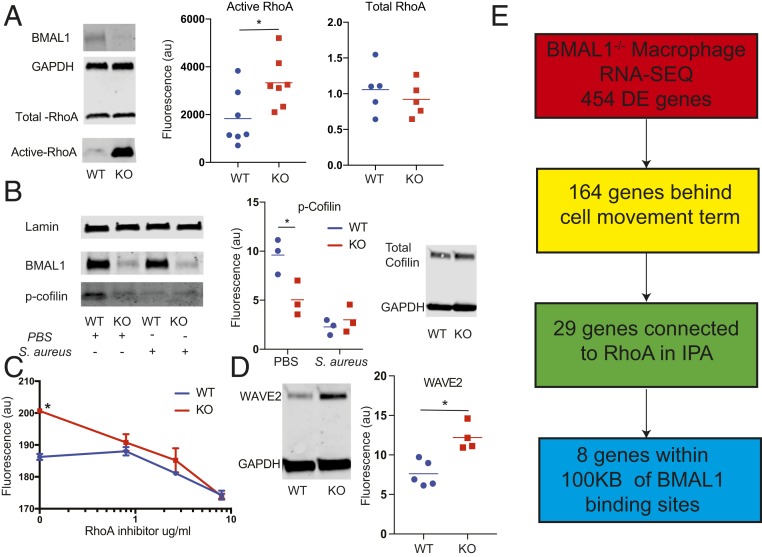
Bmal1 deletion increases RhoA activation, and inhibition of RhoA rescues the phagocytosis phenotype. (A) Peritoneal macrophages from LysM-Bmal1−/− (KO) and floxed littermate controls (WT) were cultured under control conditions for 24 h after harvest. Cells were lysed and analyzed for BMAL1, GAPDH, total RhoA, and active RhoA. Active and total RhoA abundance was quantified, after normalization to GAPDH. *P < 0.05. (B) Macrophages (WT and KO) were activated with heat-killed S. aureus for 30 min before protein lysate was analyzed for phospho, and total cofilin, with BMAL1, and lamin as controls; *P < 0.05 by Mann–Whitney U test. (C) Macrophages (WT and KO) were cultured for 24 h postrecovery from animals and then subjected to a live cell phagocytosis assay with labeled S. aureus. Cells were incubated with the CT004 RhoA inhibitor at the indicated concentrations from 1 h before adding bacteria (n = 4 per dose). Mean and SD are shown; *P < 0.05 by Mann–Whitney U test. (D) Macrophages (WT and KO) were cultured for 24 h postrecovery from animals under control conditions before lysis and analysis for WAVE2 expression by immunoblot; *P < 0.05 by Mann–Whitney U test. (E) Schematic diagram showing how 164 genes involved in the cell movement term (Fig. 3E and Dataset S2) connect to RhoA in IPA and those with transcription start sites within 100 kb of BMAL1 peaks.